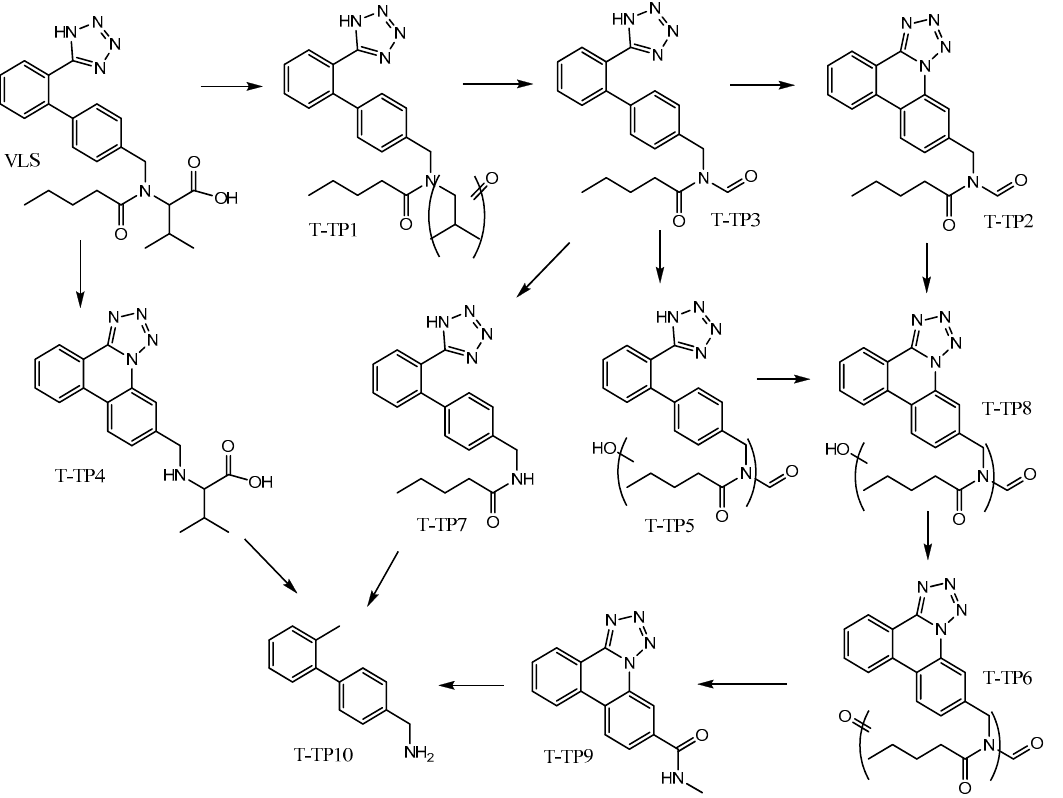
Figure 7. The proposed degradation pathways of valsartan by TiO 2 photocatalytic oxidation.